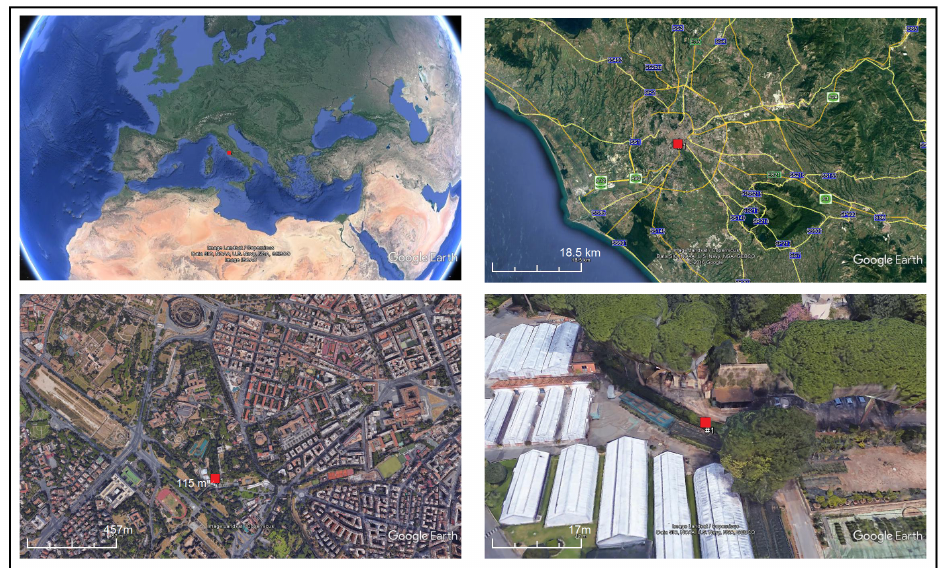
Figure 1. Location of the measurement site in the Carbonaceous Aerosol in Rome and Environs (CARE) campaign (red square, label 1) located in the Mediterranean region ( upper left panel ), in the city center of Rome ( upper right panel ), between three major traffic roads ( bottom left panel ), and in a green area ( bottom right panel )—note the different scales of the maps.